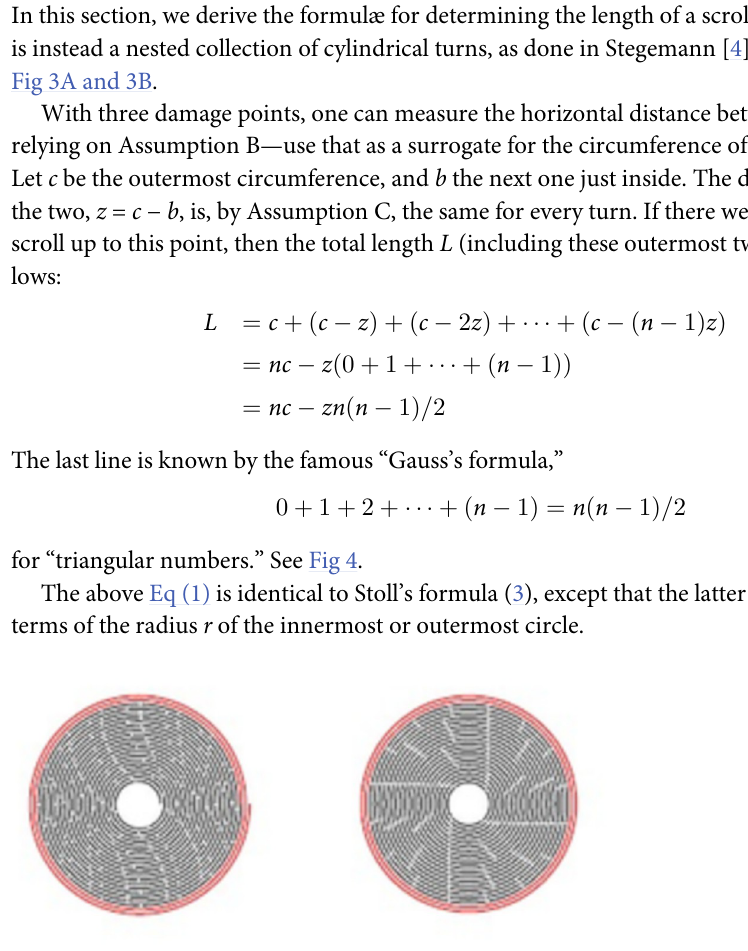
Fig 3. Approximation of spiral by circles. (A) Left: Spiral, with an increase in radius of 2 πρ = 0.1 per turn. (B) Right: Concentric circles with radii r = 0.5, 0.6, ... , 2.4, 2.5. The red solid turns are preserved; the black broken ones are to be